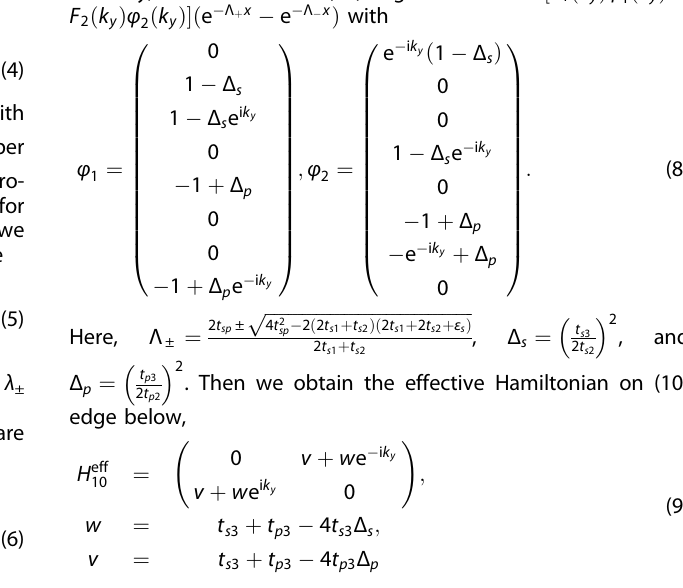
where Φ j i (cid:5) ϕ Fig. 4a. Effective Su – Schrieffer – Heeger model on (10)-edge and corner states Similarly, we derive the (10)-edge modes as ½ F 1 ð k y Þ φ